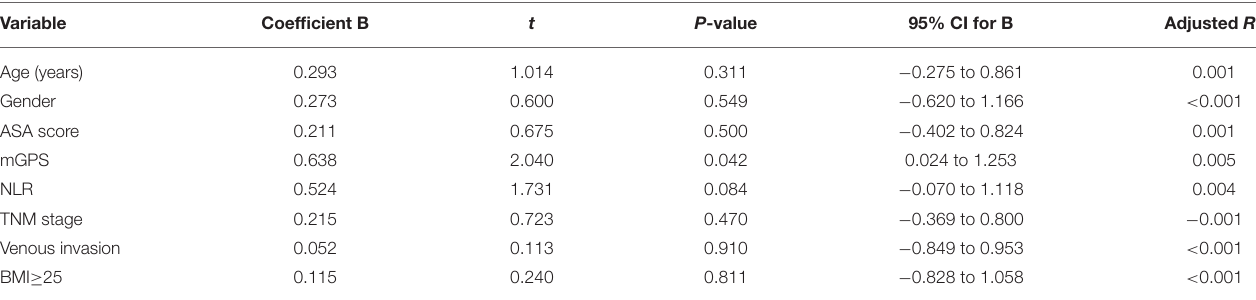
TABLE 3 | Linear regression analysis of changes in SMI against baseline clinicopathological characteristic in patients undergoing surgery for colorectal cancer.